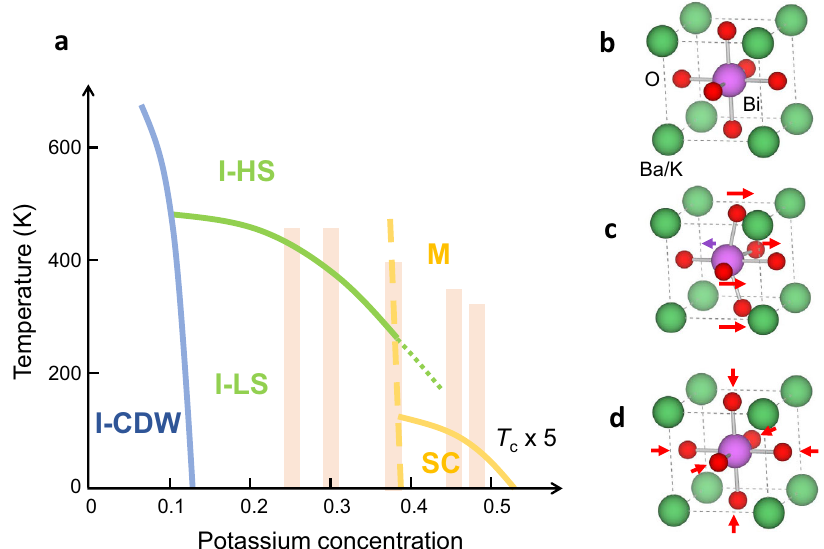
Fig. 1 | Phase diagram and unit-cell distortions in Ba 1 − x K x BiO 3 . a Schematic phase diagram based on refs. 2,7,20 . In the insulating (I) phase, there exists a com- mensurate charge-density wave (I-CDW) up to x~ 10 – 15%. Metallic (M) and super- conducting (SC) phases appear above x ~ 35%. At intermediate K concentrations, long-range CDW correlations are absent 7 ; the high-temperature structure (I-HS) is cubic, whereas long-range rigid octahedral tilts lead to tetragonal and orthor- hombic distortions at low temperatures (I-LS; see the “ Methods ” section and